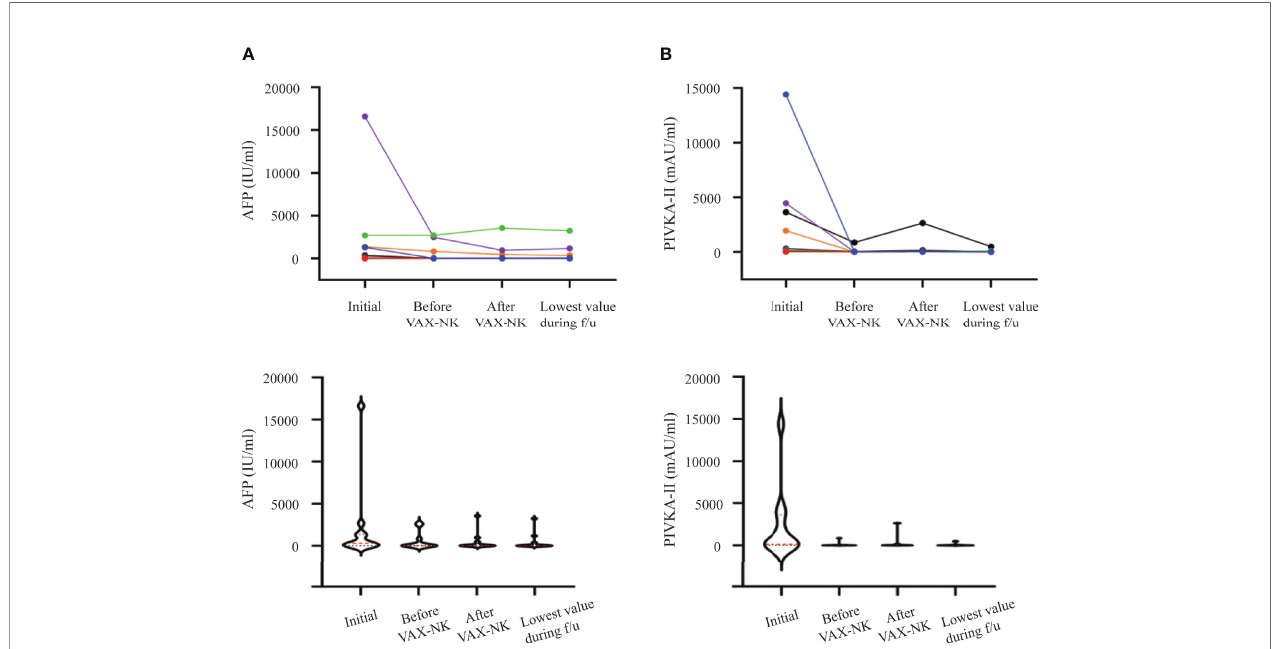
FIGURE 4 | Changes in tumor marker levels during and after treatment. (A) a -fetoprotein (AFP) (IU/mL). (B) protein-induced by vitamin K absence or antagonist-II (PIVKA-II) (mAU/mL). NK, natural